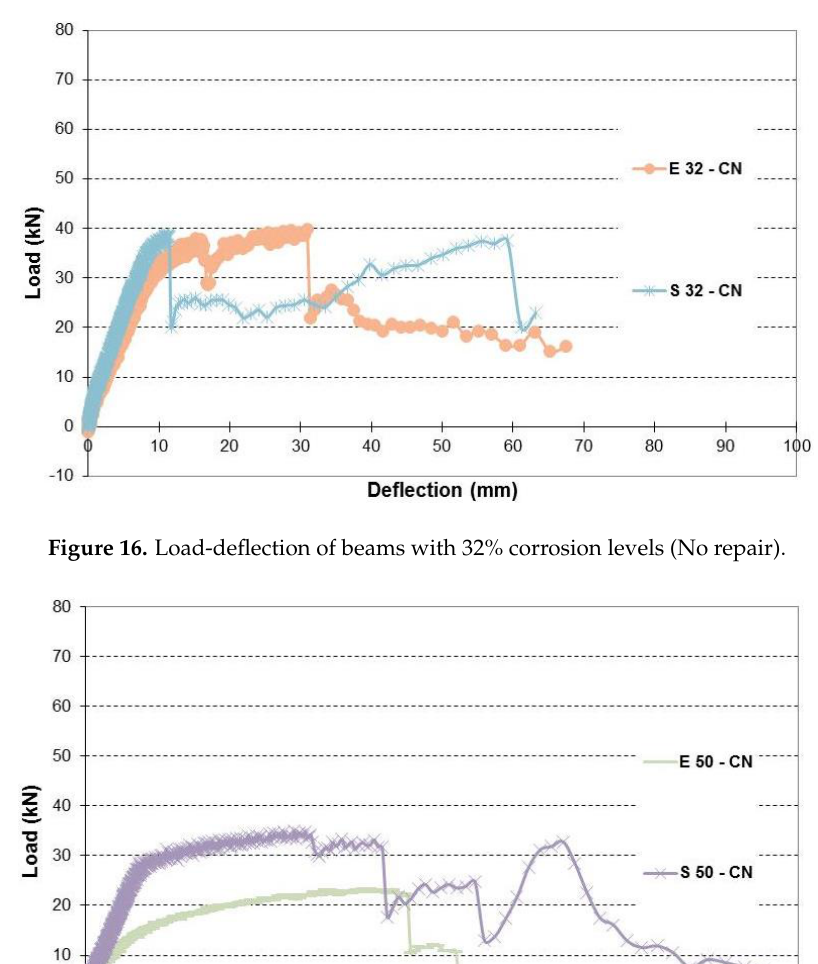
Figure 15. Load-deflection of beams with 20% corrosion levels (No repair).